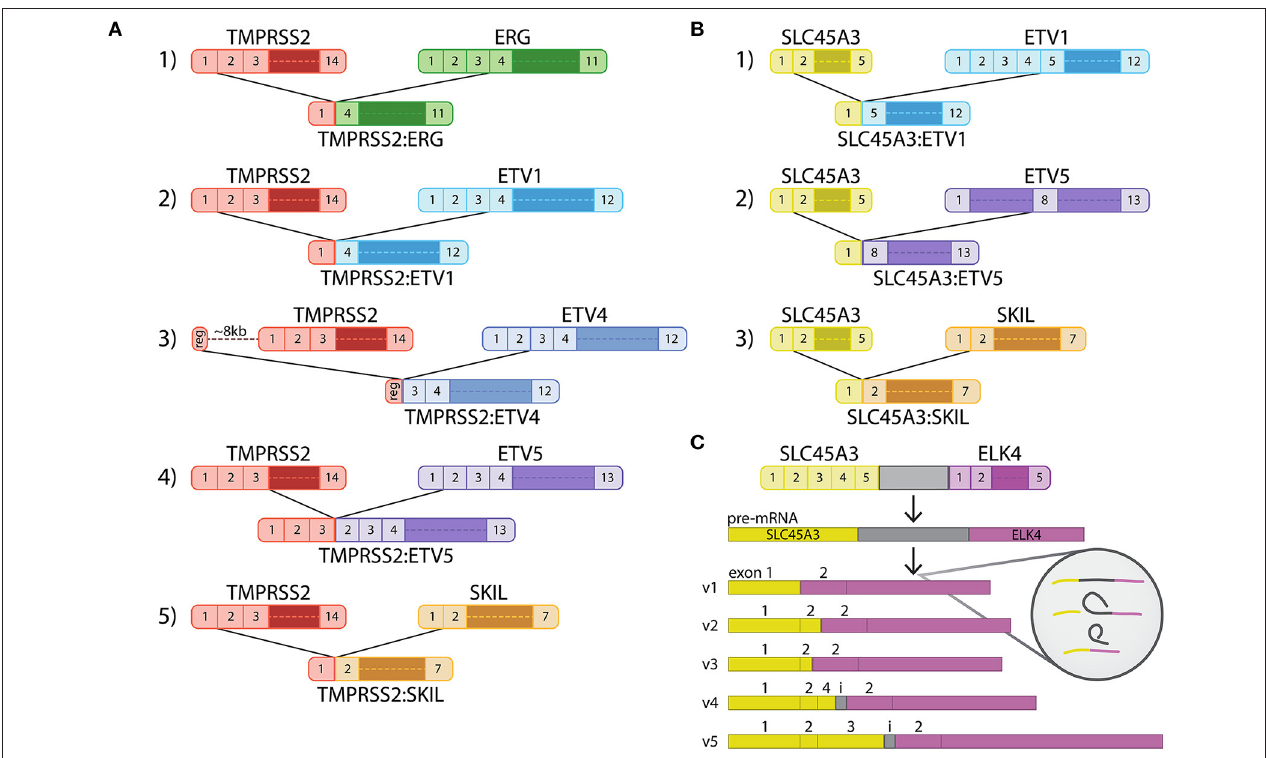
FIGURE 2 | Structure of the most common and relevant androgen-driven fusion genes in prostate cancer. (A) Fusion genes involving TMPRSS2 as the 5 ′ partner. (B) Fusion genes involving SLC45A3 as the 5 ′ partner. (C) Splice variants of the chimeric SLC45A3:ELK4 fusion transcript.